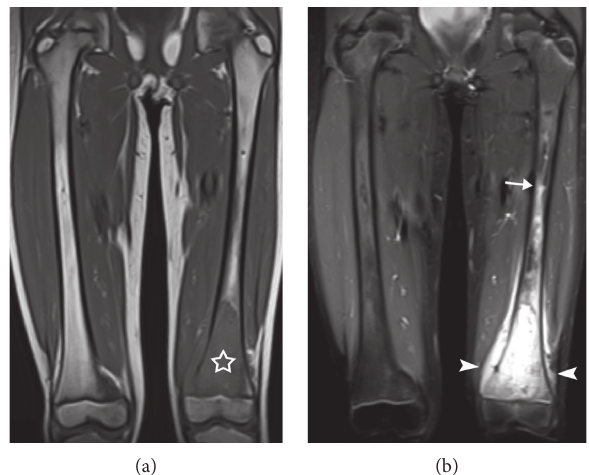
Figure 2: Magnetic resonance imaging (MRI) of the thighs. Coronal T1-weighted (a) and fluid-sensitive (b) large-field-of-view images confirm a marrow replacement process centered within the left distal femoral metaphysis (star) with extraosseous extension (arrowheads) and proximal marked peritumoral bone marrow edema-like signal (arrow).